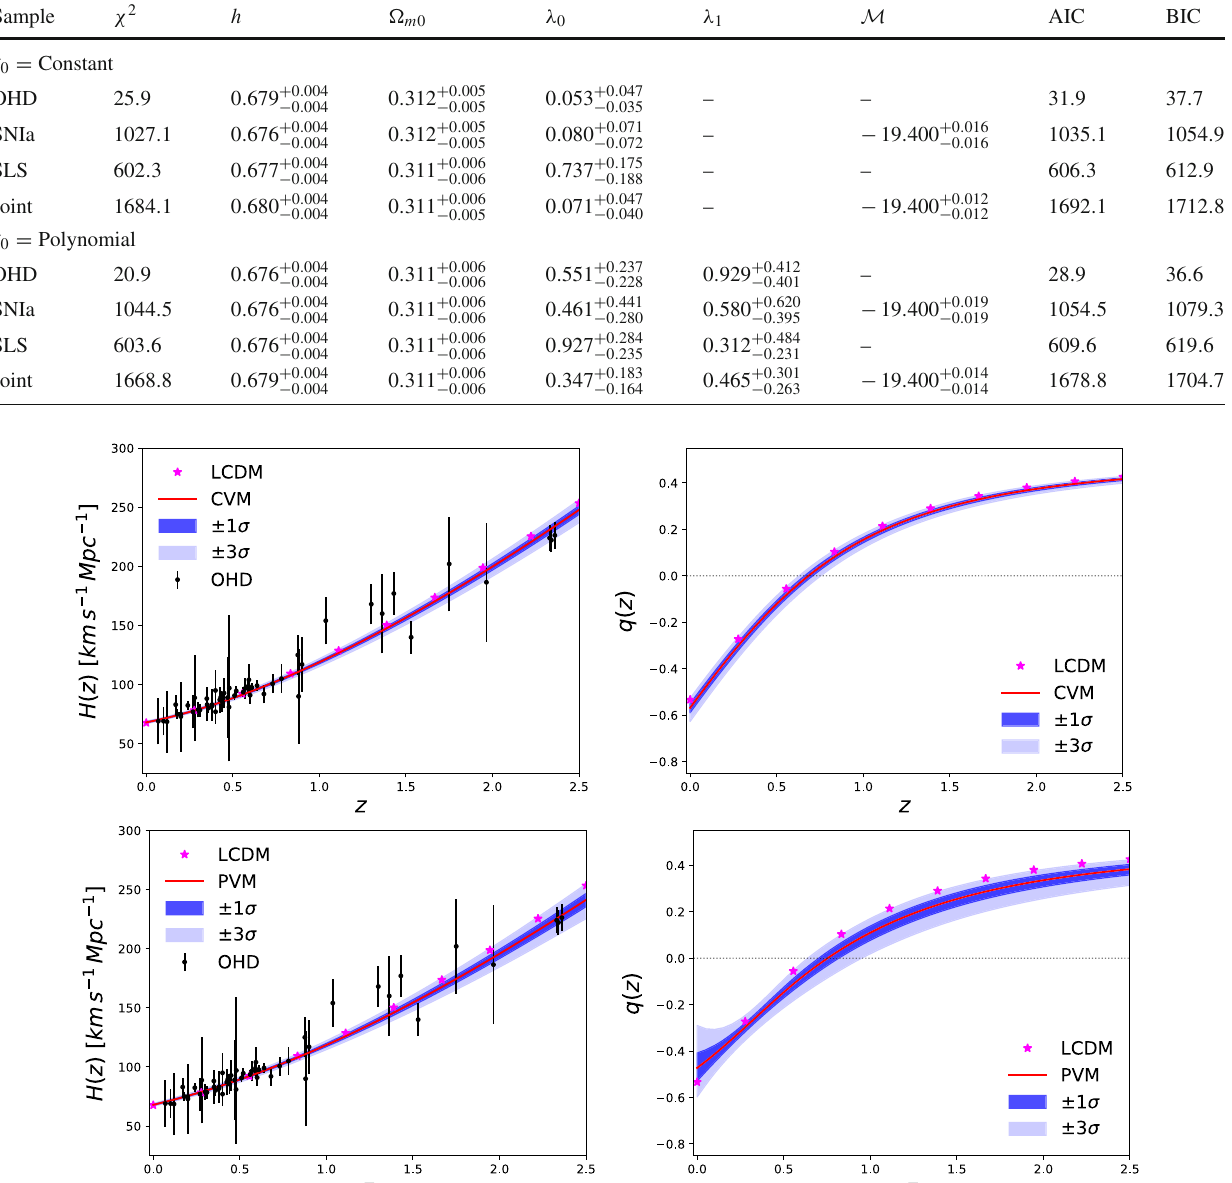
Table 2 Best fitting values of the free model parameters